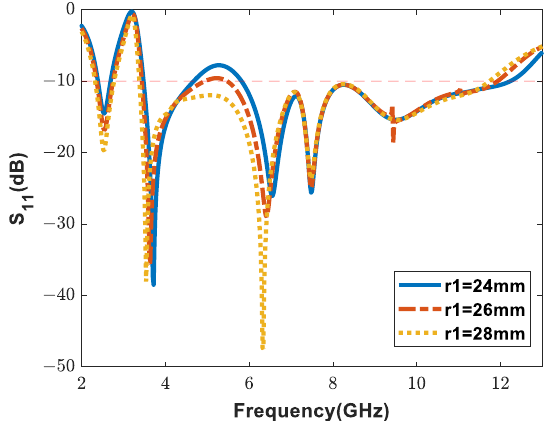
Figure 5. S-parameter according to the size of r1.